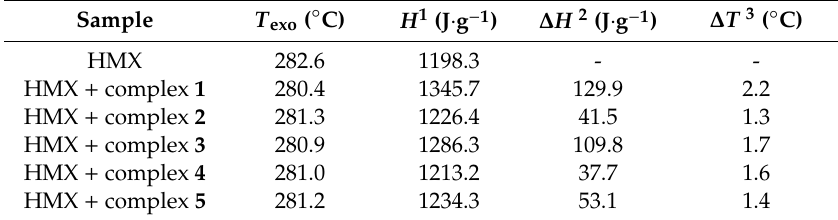
Table 1. Promoting e ff ect of complexes 1 to 5 on the thermal decomposition of HMX